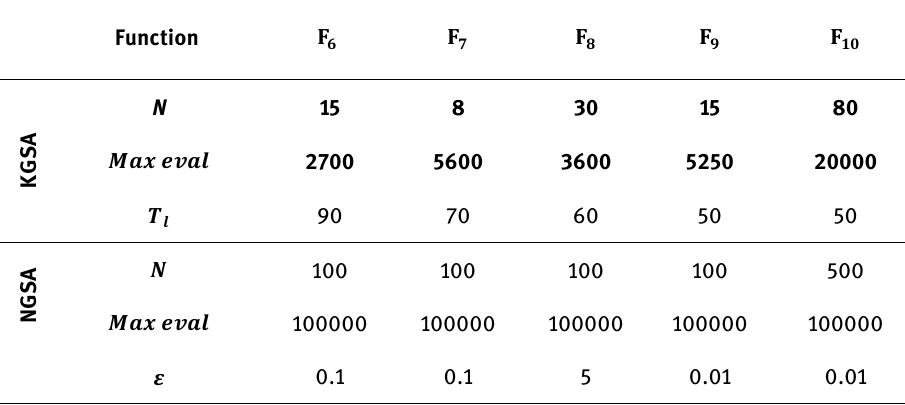
Table 6A: List of required parameters for discovering local and global optima in Table 8